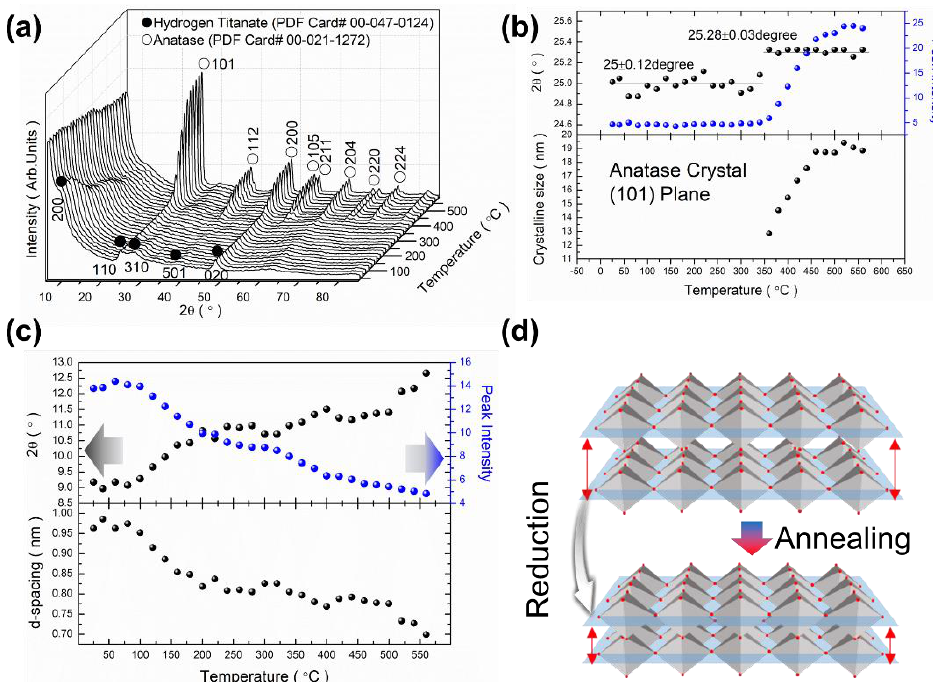
Figure 4. ( a ) In situ X-ray diffraction (XRD) patterns of the PTNTs during an annealing temperature. ( b ) Annealing temperature e ff ect on the variations of 2 θ and Peak intensity assigned to the 110 hydrogen titanate and 101 anatase reflections, and the crystal size of the anatase phase. ( c ) Annealing temperature e ff ect on the variations of 2 θ and peak intensity assigned to the 200 hydrogen titanate reflection and d -value derived from 2 θ . ( d ) Illustration for variation of interlayer distance by annealing.